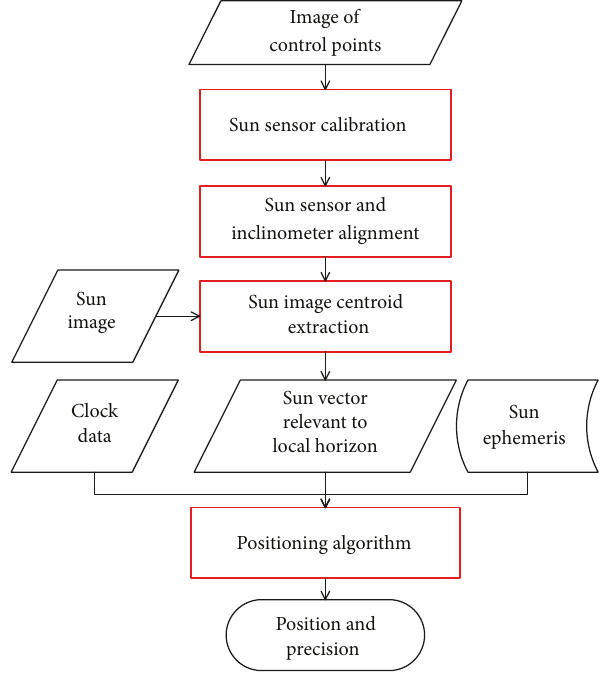
Figure 9: Flow chart of heading-determination